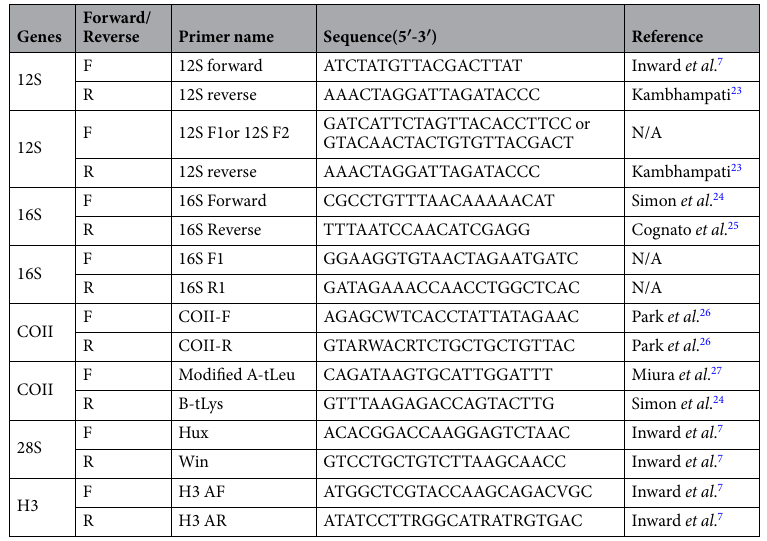
Table 1. Primers used to generate sequences. N/A: primers were designed for this